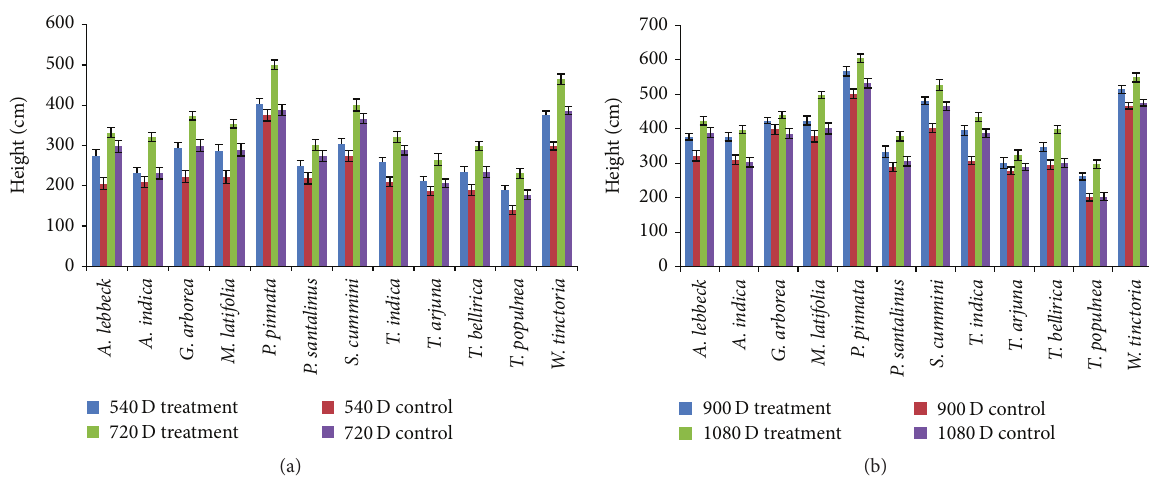
Figure 1: (a) Above-ground heights of the 12 different plant species in field experiment using application of the PGPB consortium and control for 540–720 days. (b) Above-ground heights of the 12 different plant species in field experiment using application of the PGPB consortium and control for 721 to 1080 days.